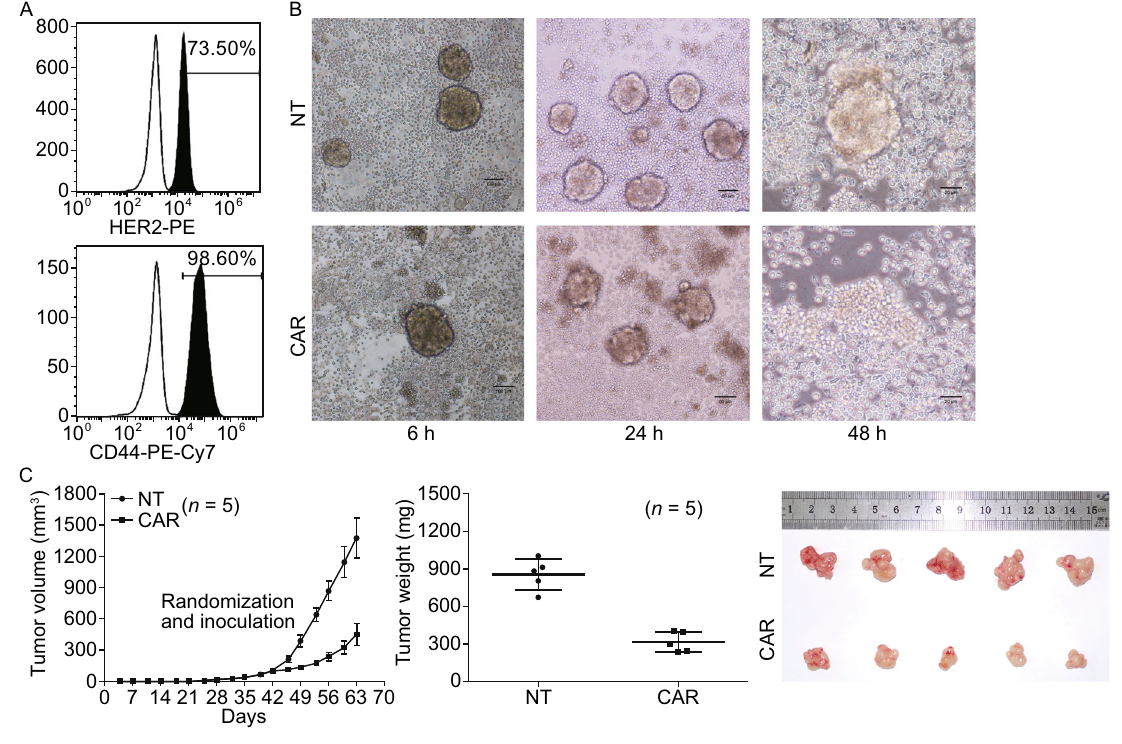
Figure 5. Effective response by CART-HER2 cells to GCSCs. (A) FACS analysis was used to determine the surface expression of HER2 and CD44 proteins in gastric cancer stem cells from suspended tumor spheres. (B) Co-culture of tumor spheres with 2 × 10 5 CART-HER2 cells, or NT Tcells, per well was performed in an ultra-low adherent 24-well plate using serum-free media. Images of the killing activity, exerted by CART-HER2 cells against tumor spheres at serial time points, are shown. (C) Ten thousand gastric cancer stem cells were injected subcutaneously into the unilateral axillary region of BALB/c nude mice on day 0. Five mice per group were randomized to the CART-HER2 and NT groups. When the mean tumor volume reached approximately 100 mm 3 on day 42, intravenous treatment with T cells was performed. Mice with maximum tumor diameters over 2 cm were sacri fi ced on day 63. The tumor volume data are represented as mean ± SD (mm 3 ). The tumor weight data are represented as mean ± SD (mg). Images of tumor samples from sacri fi ced mice